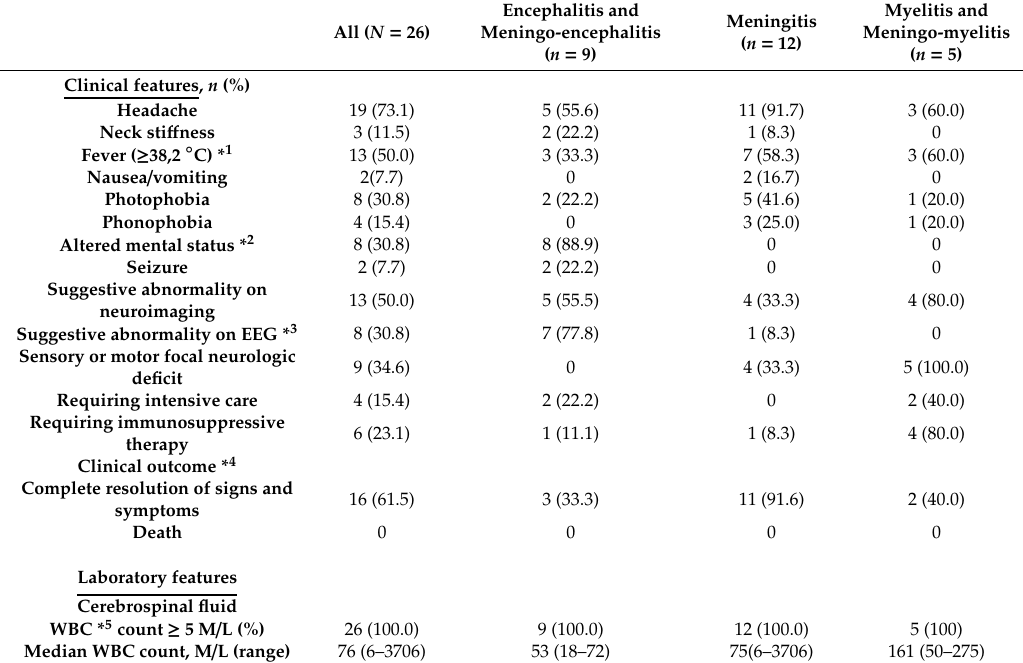
Table 4. Clinical and laboratory data of the 26 patients with CNS inflammation of unknown origin. All ( N =